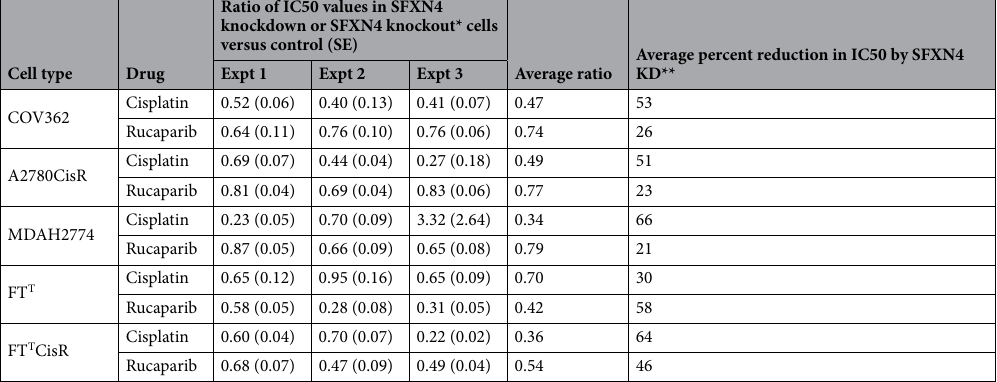
ovarian adenocarcinoma cells 38 . We also created a drug resistant model of FT T cells (termed FT T CisR) using long- term culture of cells in low concentrations of cisplatin, as previously described for other cell types 38 . The IC50 of cisplatin in both A2780CisR and FT T cisR was increased two- to threefold compared to their respective parental cells (IC50 A2780, 26 ± 10 μM; A2780CisR, 69 ± 24 μM; IC50 FT T 16 ± 4.4, FT T CisR 53 ± 13, means and S.E.,